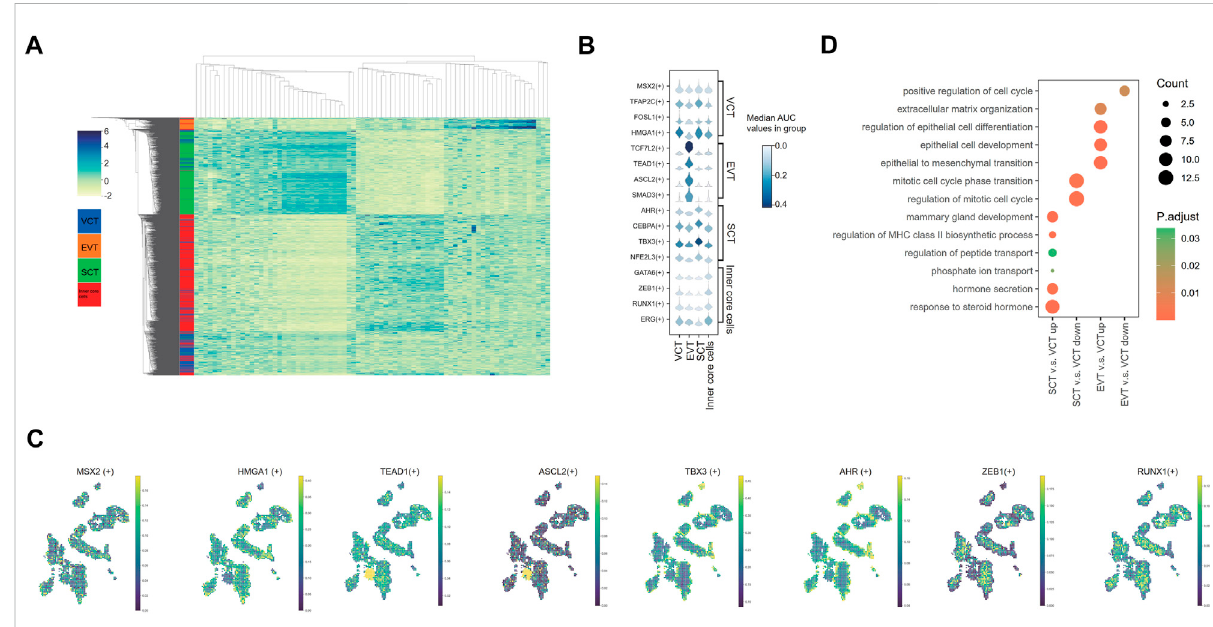
FIGURE 4 Analysis of the spatial regulatory activity of transcriptionfactors in villi. (A) Heatmap of AUC Z-scores for the cell-type-speci fi cregulons (B) The AUC score levels of representative regulons. (C) Distribution of the representative regulons. (D) GO pathway analysis of differentially expressed